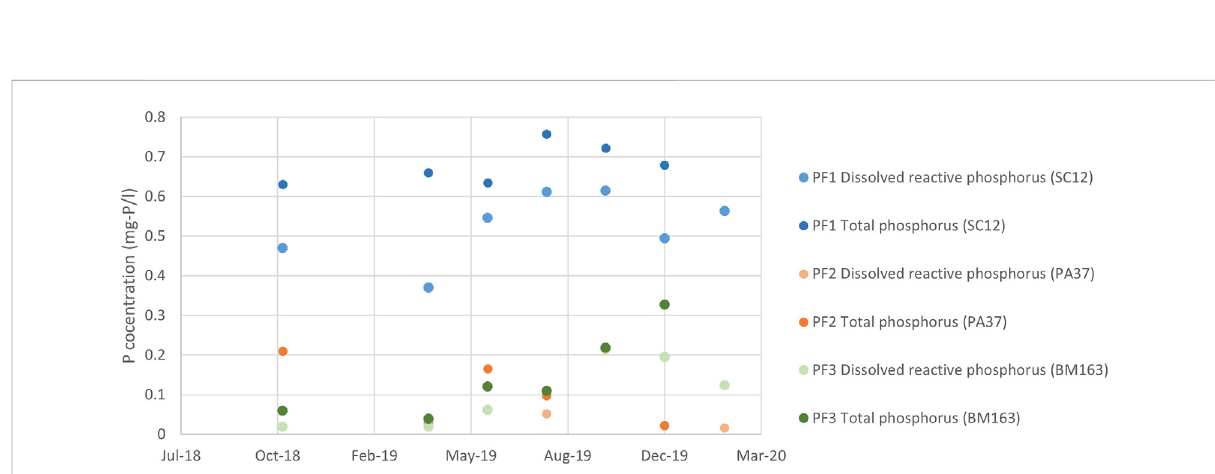
vegetation or cycled into lower sediments rather than the nutrient feed needed to sustain the fen. These levels are also a re fl ection of the dilution by rainwater evident from the mixed surface/groundwater at phreatic levels. The reported values in